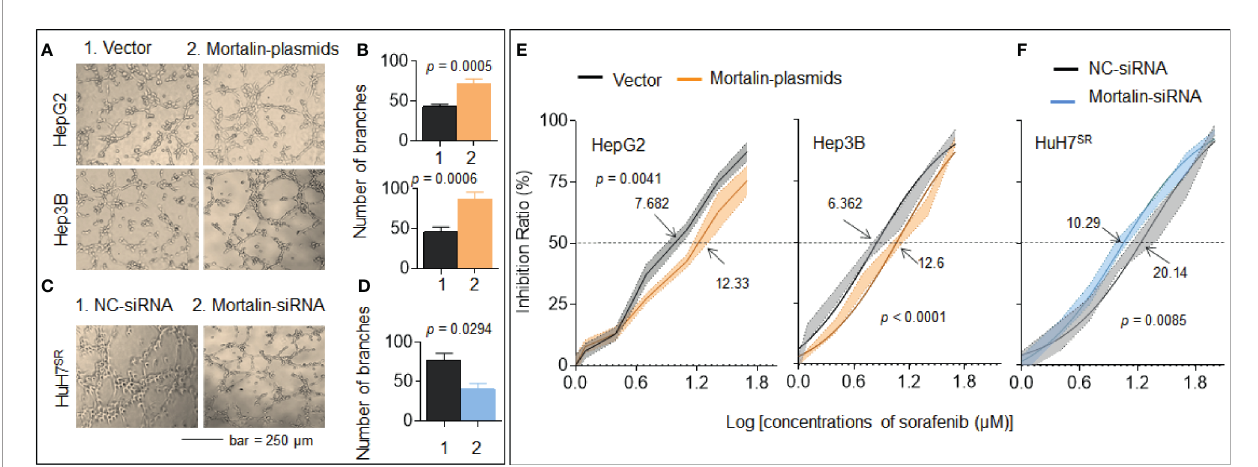
FIGURE 1 | Mortalin causes angiogenesis and sorafenib resistance in hepatocellular carcinoma (HCC) cells. HepG2 and Hep3B cells were transfected with mortalin- plasmids, and HuH7 SR cells were transfected with mortalin-siRNA. (A, C) Capillary tube formation assay of the effects of mortalin on tube formation in human umbilical vein endothelial cells (HUVECs). (B, D) Quantitative analysis, determined in triplicate, of tube formation. The differences were analyzed by Student ’ s t -test. (E, F) After the three HCC cell types were transfected with mortalin-siRNA or mortalin-plasmids, they were treated with different concentrations of sorafenib for 24 h. The cell viability was determined in triplicate, and IC 50 values were calculated. The differences were analyzed using two-way analysis of variance followed by Sidak ’ s multiple comparison